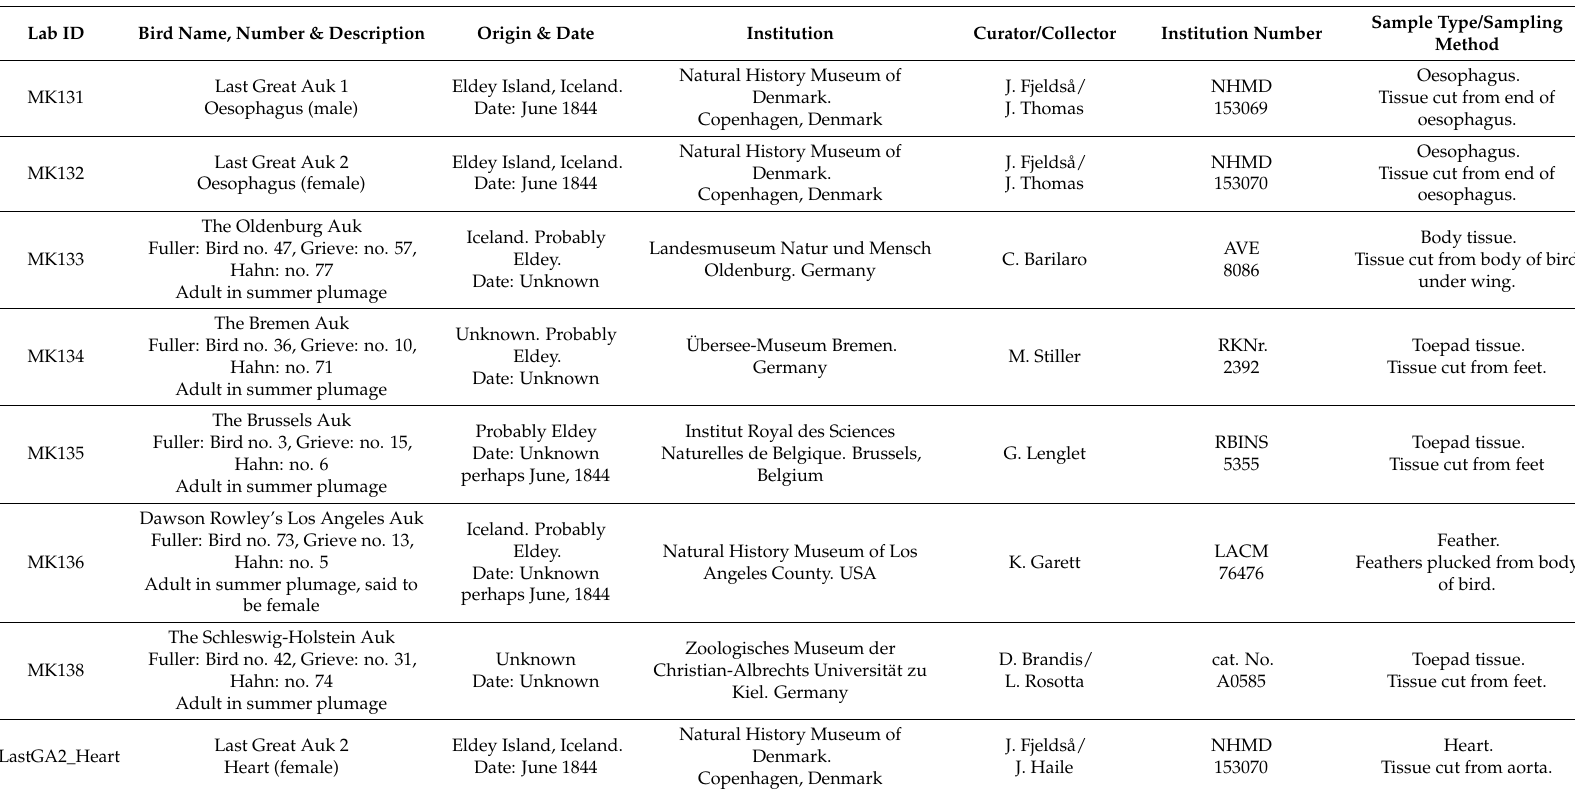
Table 1. Sample information. Lab ID number used during laboratory and analysis process. Mount name and description given by Fuller and its number in various published lists of Great Auk mounts [3]. Origin and date information as noted by Fuller [3]. Institution information relating to the present location of specimen and the curator/sample collector